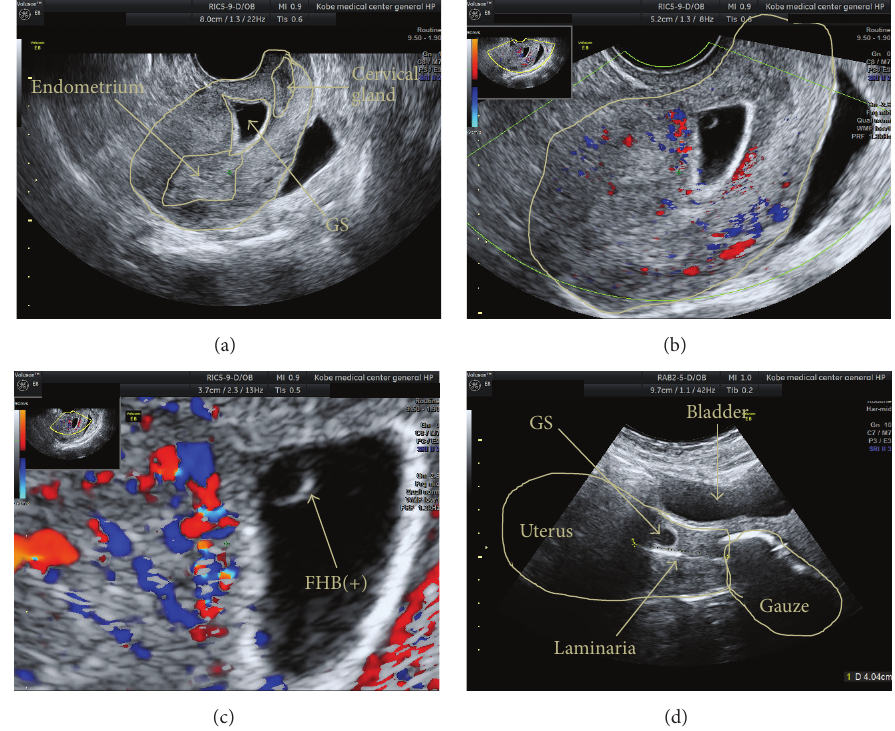
Figure 1: Ultrasonographic findings in cesarean scar pregnancy. (a) The gestational sac (GS) was located in the cesarean scar pouch. The uterine cavity and cervical glands were empty. (b) The GS was triangular in shape inside the cesarean scar pouch. (c) Fetal heartbeat was positive in the hyperechoic portion of the Yolk Sac, and the fundal side of the triangular-shaped GS was rich in blood supply. (d) The GS shape changed to round after insertion of the Laminaria